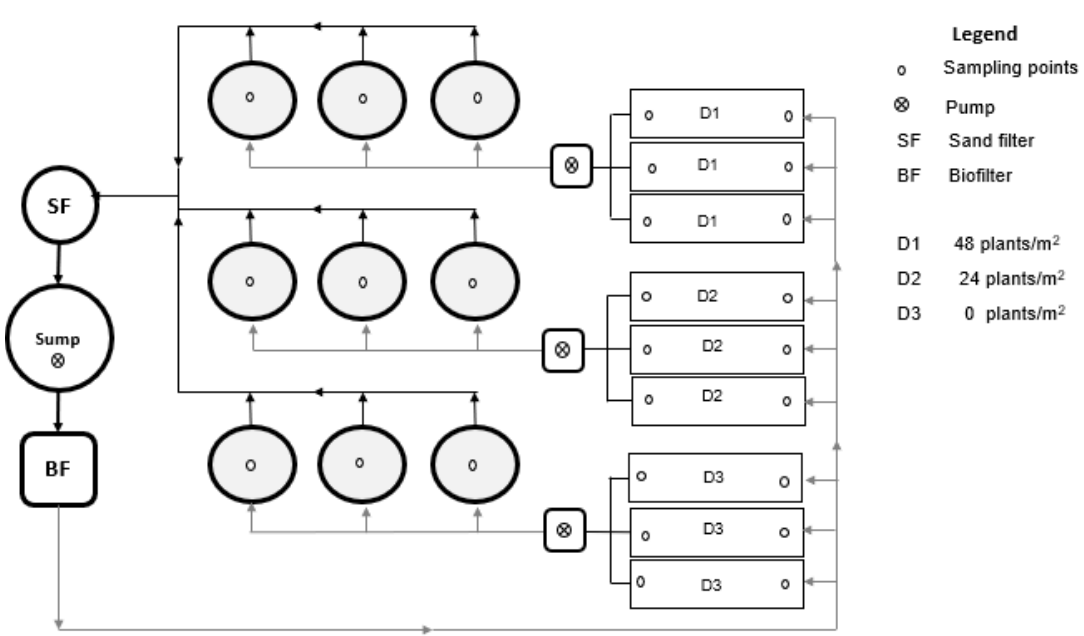
Figure 1. The experimental aquaponic system (not drawn to scale). Grey circles represent fish rearing tanks, rectangular boxes; hydroponic units, grey and black lines with arrows indicate the direction of water flow with grey representing inlet and black the outlet.